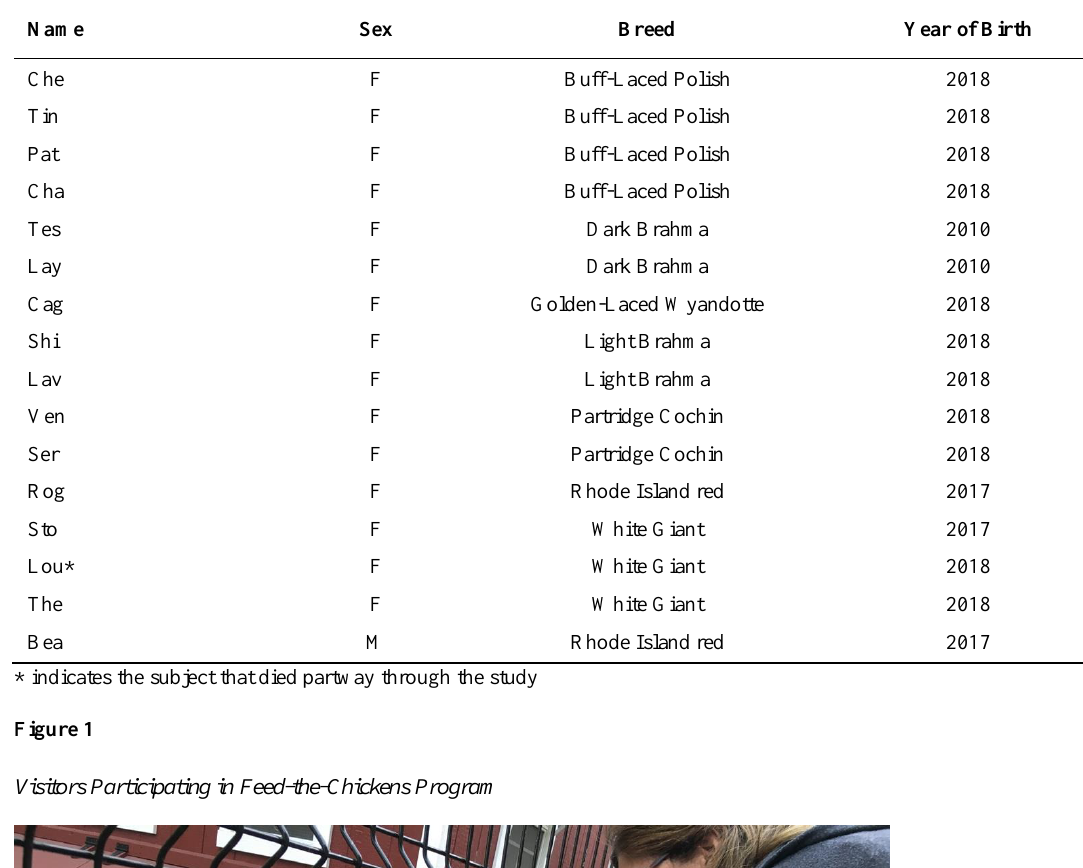
Sex, Breed, and Birth Year of the Chickens in this Study